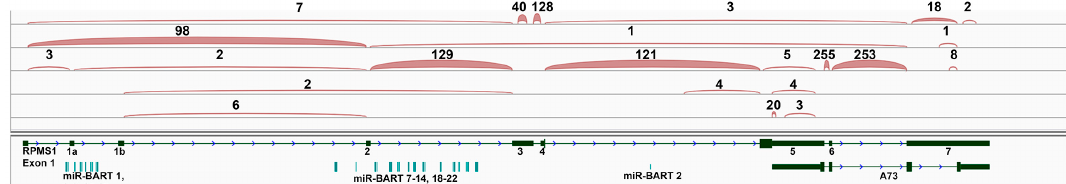
Figure 6. Alternative splicing in the EBV BamH1 A region in EBV-high NSCLC. RNA-seq data of the EBV-high NSCLC were analyzed using the STAR aligner and were aligned to the modified Akata-EBV genome to obtain splice junction information. Junctions were visualized using the Integrative Genomic Viewer (IGV). The thickness of the red junction features correlates with the number of reads for the respective junction. The number of junction spanning reads for each junction is indicated above each junction feature.